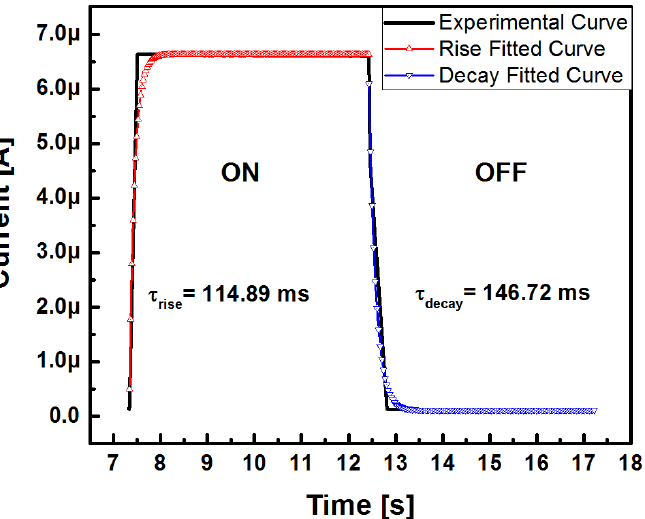
Figure 15. Fitted curves of the photoresponse to white light irradiation and switching response time-resolved for the Au/SRO/Si structures.